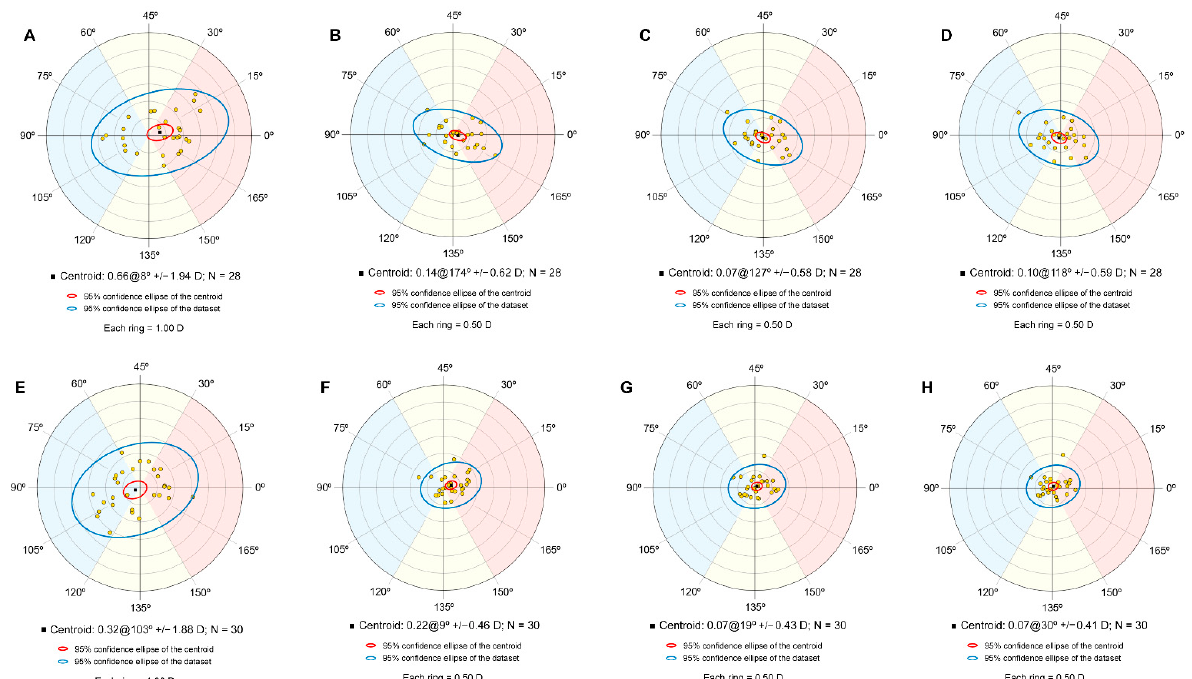
Figure 1. Preoperative anterior corneal astigmatism in the Phaco group ( A ) and prediction errors without considering posterior corneal astigmatism ( B ), estimation with Abulafia-Koch formula ( C ) and Barrett formula ( D ). Preoperative anterior corneal astigmatism in the Femto group ( E ) and prediction errors without considering posterior corneal astigmatism ( F ), estimation with Abulafia-Koch formula ( G ) and Barrett formula ( H ).